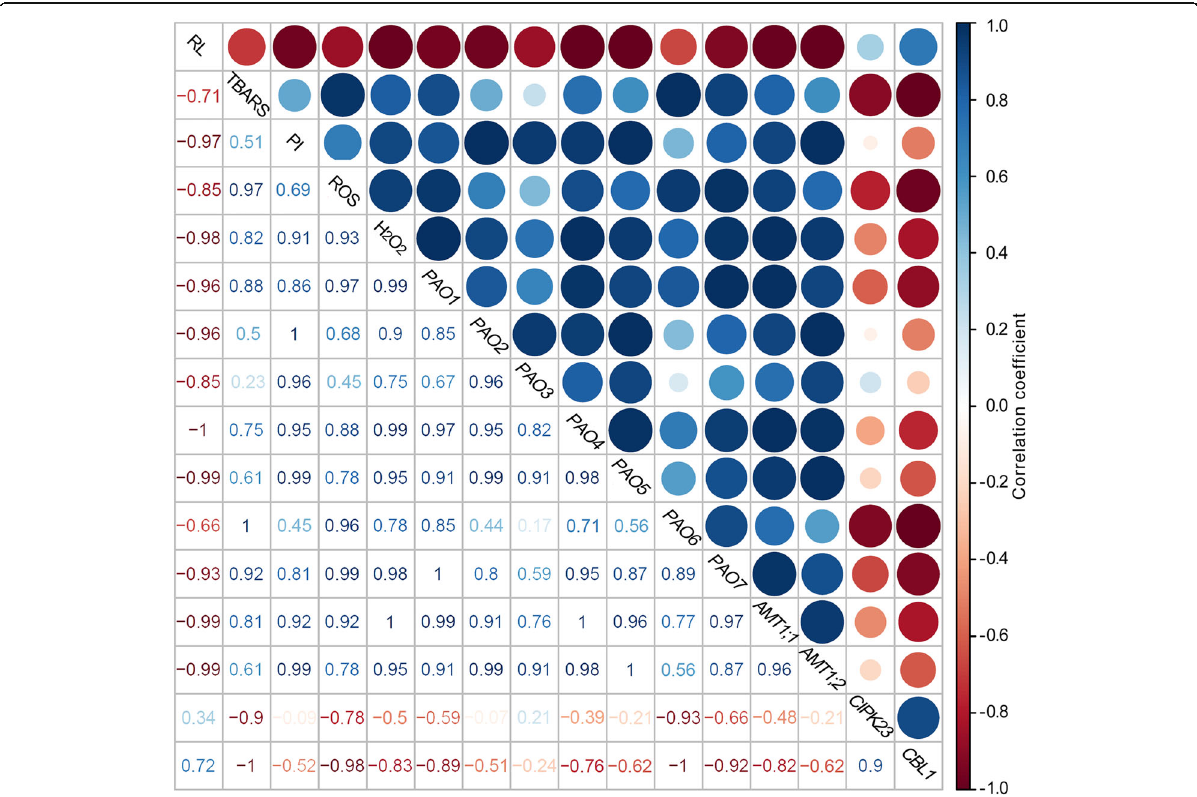
Fig. 6 Pearson correlation analysis of different physiological parameters in rice root under treatment of control, NH 4 Cl, and NH 4 Cl +